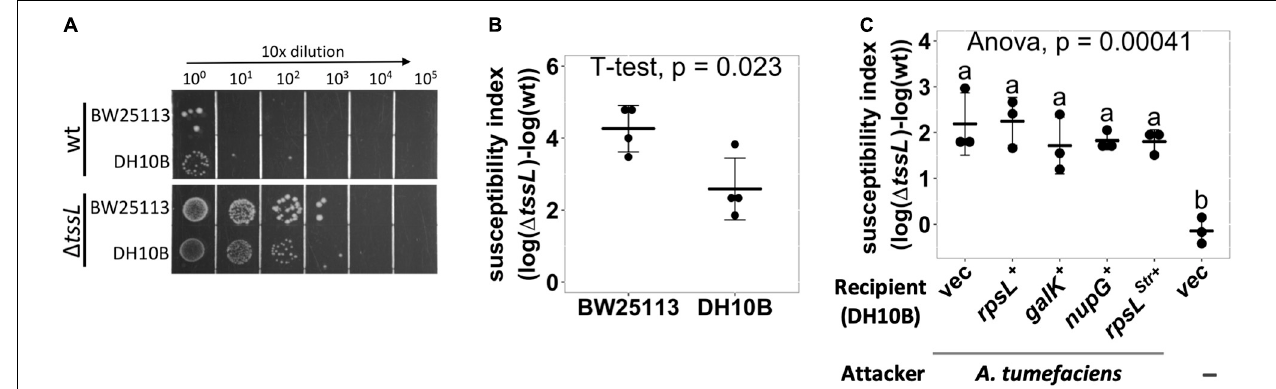
FIGURE 1 | Agrobacterium tumefaciens type VI secretion system (T6SS)-dependent antibacterial activity against Escherichia coli strains. (A,B) A. tumefaciens T6SS antibacterial activity against E. coli strains DH10B and BW25113. A. tumefaciens was co-cultured at a ratio of 30:1 with E. coli DH10B or BW25113, both E. coli strains harboring vector pRL662, on Agrobacterium Kill (AK) agar medium for 16 h. The bacterial mixtures were serially diluted and spotted (A) or quantified by counting cfu (B) on gentamicin-containing lysogeny broth (LB) agar plates to selectively recover E. coli . (C) E. coli DH10B was complemented by either vector only (vec) or derivative expressing rpsL , galK , nupG , or rpsL Str in trans before being subjected to A. tumefaciens T6SS-dependent antibacterial activity assay as described in (B) . Susceptibility index (SI) was defined as the subtraction difference of the recovery log(cfu) of that attacked by (cid:49) tssL to that attacked by wild-type A. tumefaciens C58. Data are mean ± SD of three independent experiments calculated by t -test with P < 0.05 for statistical significance (B) or single-factor analysis of variance (ANOVA) and Tukey honestly significant difference (HSD), in which two groups with significant differences are indicated with different letters (a and b) (C)